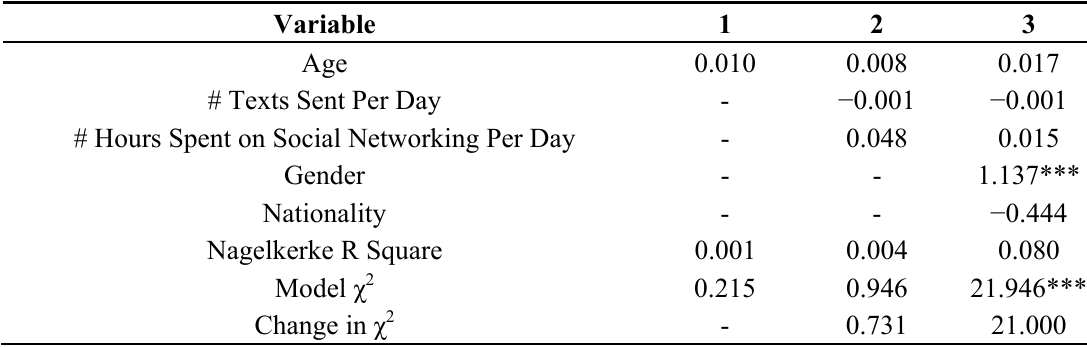
Table 6. Logit estimates of characteristics on attitudes toward punishment of virtual relationship violence (N =